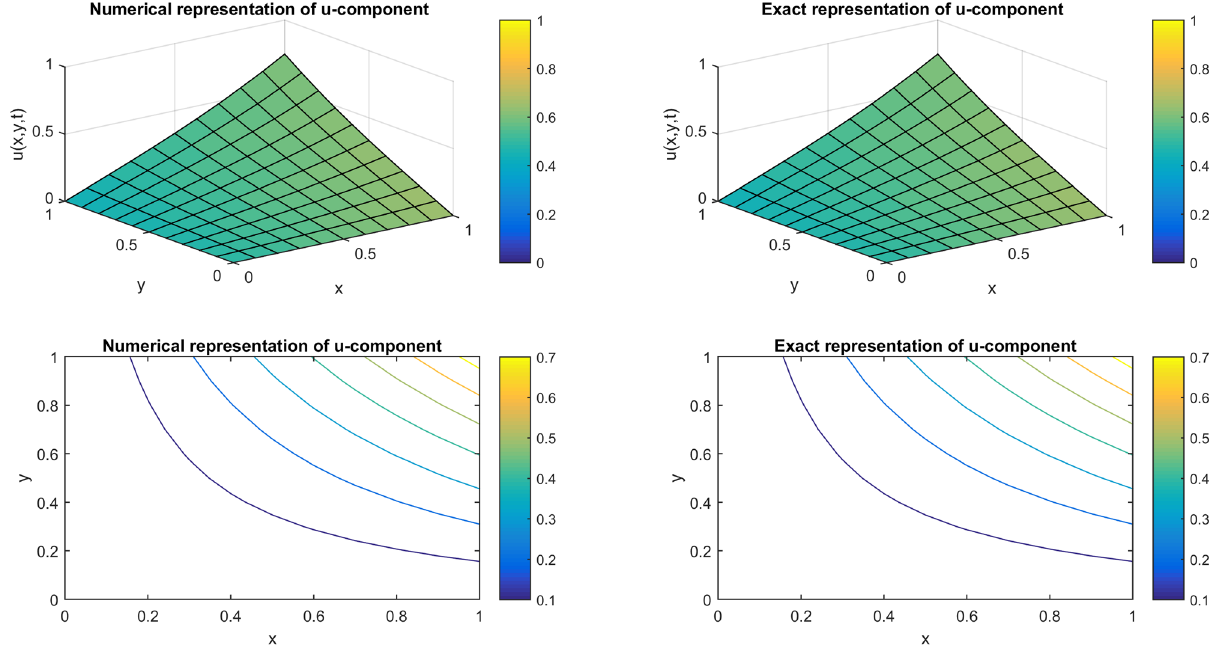
Figure 14: Surface and contour plots for u component at = t 1 for = N 11 , = α 50 , = β 5 , = t Δ 0.0001 , and = τ 0.5 using Method II regarding Example